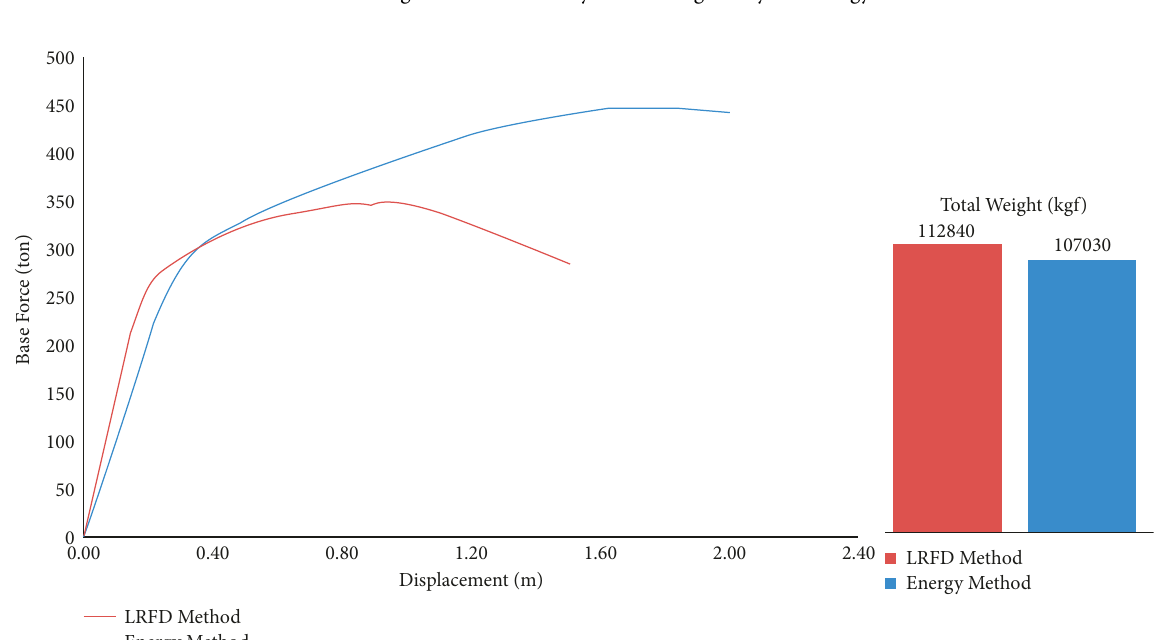
Figure 19: Comparing the push diagram and weight of the 16-story steel frame designed by the energy and LRFD methods.